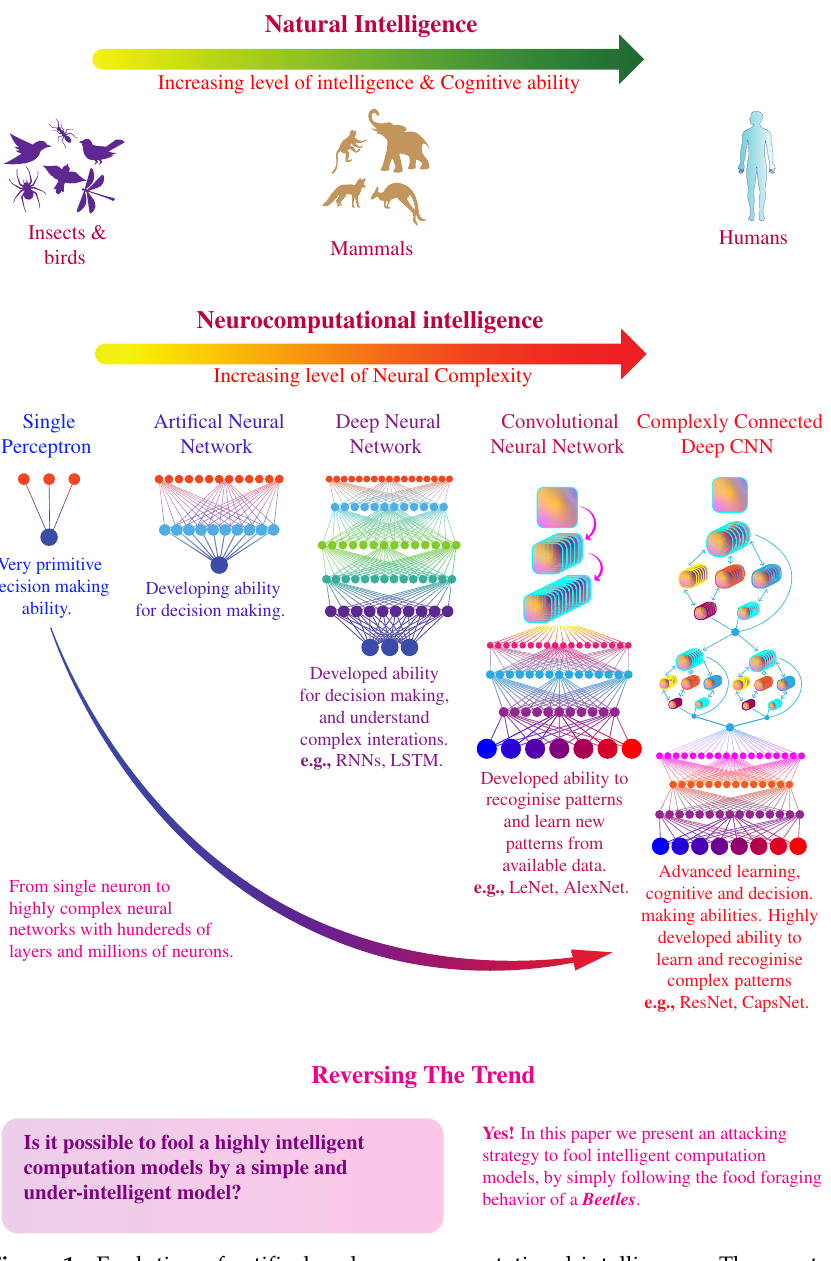
Figure 1. Evolution of artifical and neurocomputational intelligence. The spectrum of natural intelligence ranges from simple organisms to highly intelligent human brains. The spectrum of artificial neurocomputational intelligence also follows a similar trend in term of complexity and ranges from single perceptron to multi-layered neural networks comprising of millions of